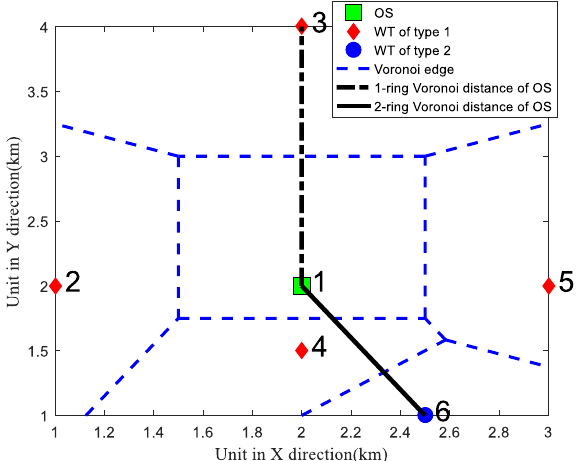
Figure 3. Voronoi diagram of a multiple wind turbine types offshore wind farms.